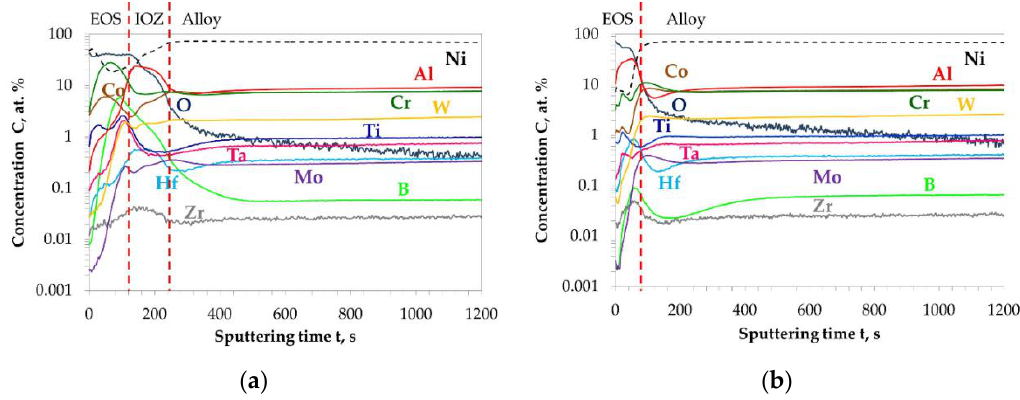
Figure 3. GD-OES depth profiles obtained on Mar M 247 after isothermal air oxidation at 1000 °C up to 48 h with: ( a ) Polished surface; ( b ) Ground surface. The red dashed lines virtually indicate the regions of external oxide scale (EOS), internal oxidation zone (IOZ) and metallic alloy.